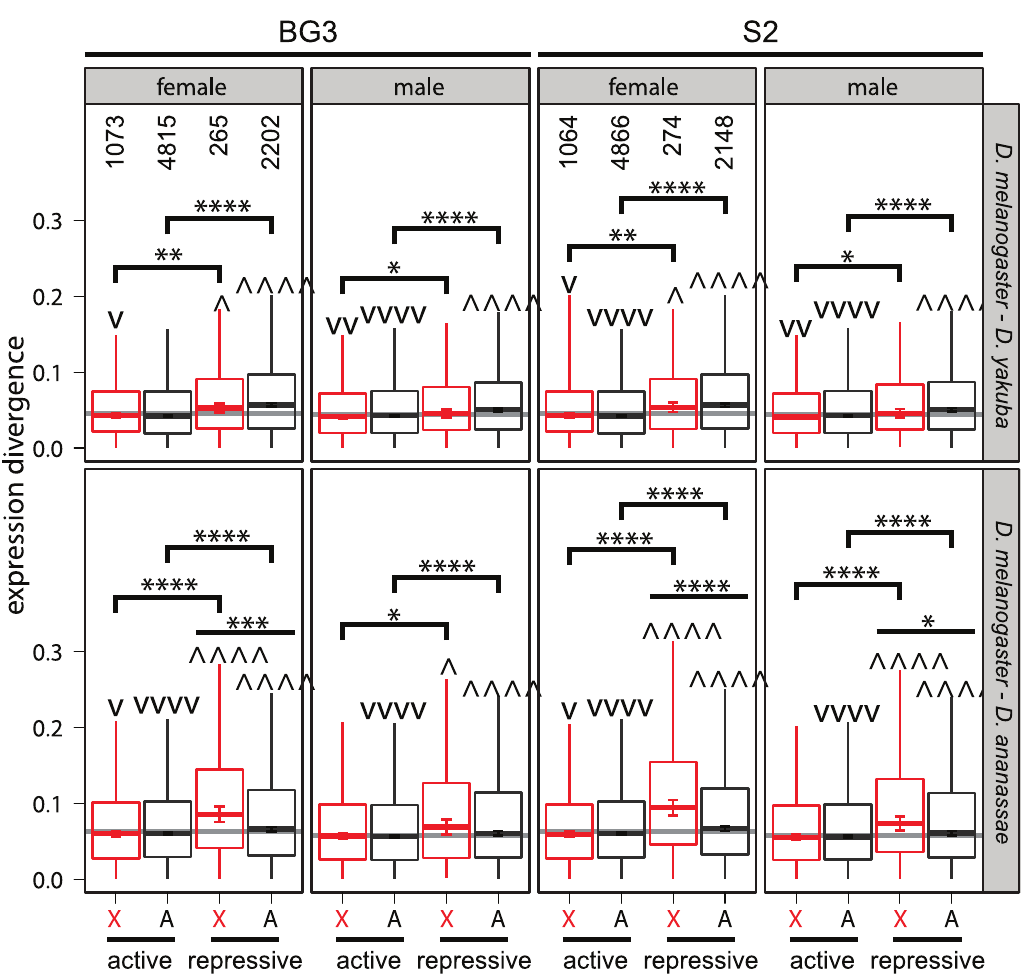
Figure 6. Faster expression evolution of genes associated with transcriptionally repressive chromatin. Boxplots show the pairwise divergence in expression between 1:1:1 orthologs in the D. melanogaster and D. yakuba or D. ananassae genomes measured in whole females and males (see Figure 5). X-linked (X, red) and autosomal (A) genes were assigned to transcriptionally active and repressive chromatin based on the results of ChIP-chip experiments in one of two cell lines (BG3 and S2) [65]. Counts of genes in each chromatin state are given for data collected from each of the cell lines in the top left quadrants. Groups of genes whose pairwise divergence is greater () or less (v) than the rest of the genome are marked. Comparisons were also made between genes in active and repressive chromatin on the X chromosome or autosomes, and comparisons were made between autosomal and X-linked genes in active or repressive chromatin. Mann-Whitney U tests were used to assess significant differences (one symbol= P v 0 : 05 , two symbols= P v 0 : 005 , three symbols= P v 0 : 0005 , four symbols= P v 0 : 00005 ).